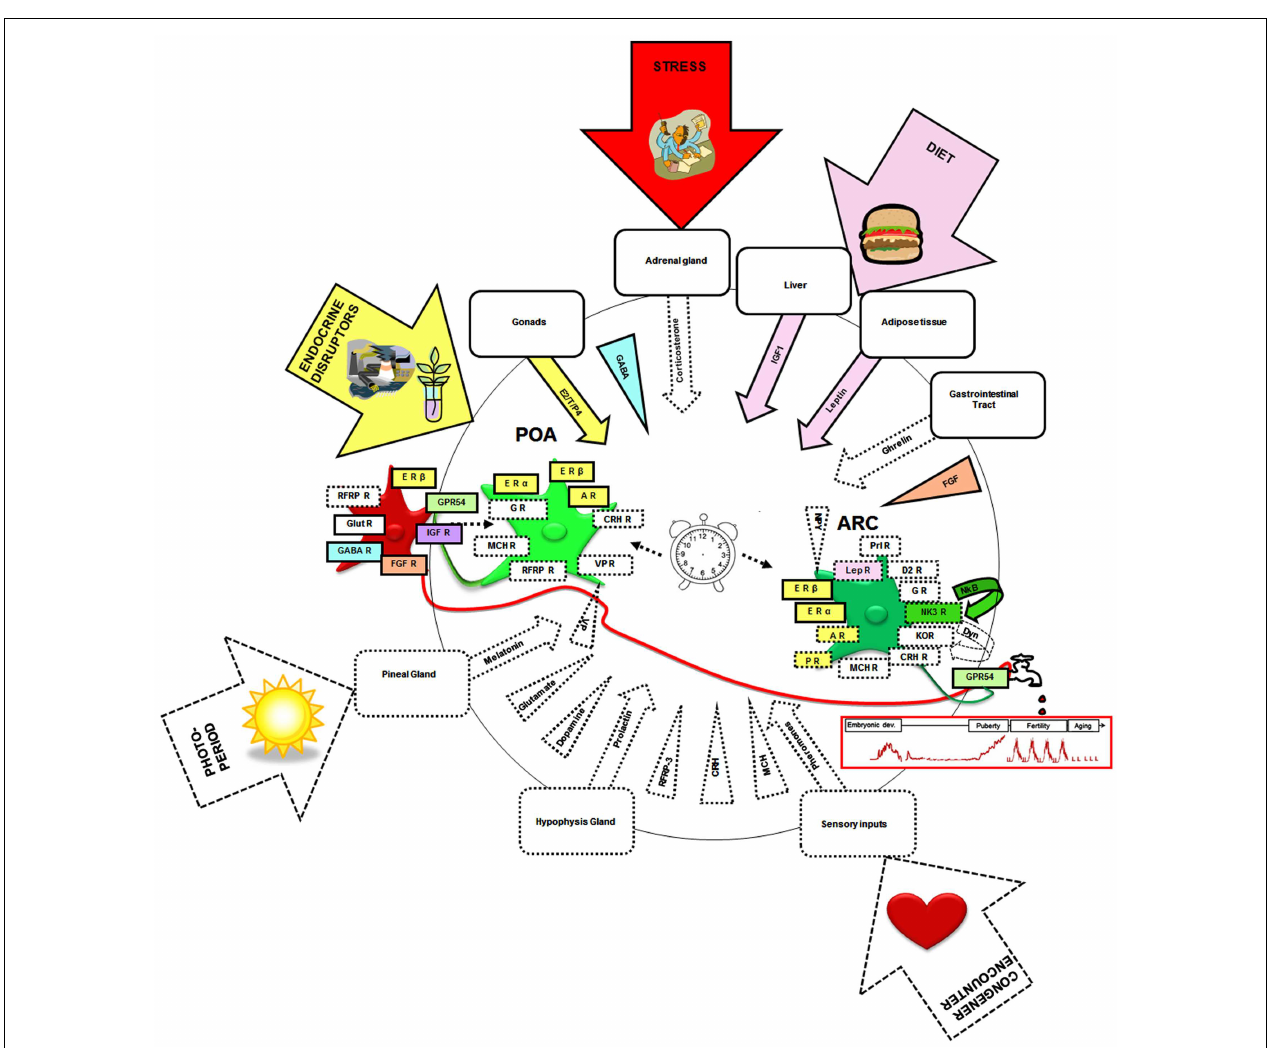
FIGURE 4 | Neural, hormonal, and environmental factors regulating the kisspeptin–GPR54 system. Scheme summarizing the different factors that have been shown to regulate the kisspeptin–GPR54 system only during adulthood (squared by dashed lines) or also during development (squared by full lines and colored). Hormonal factors are codified by an arrow and central factors by a triangle. Molecular factors have been included whose